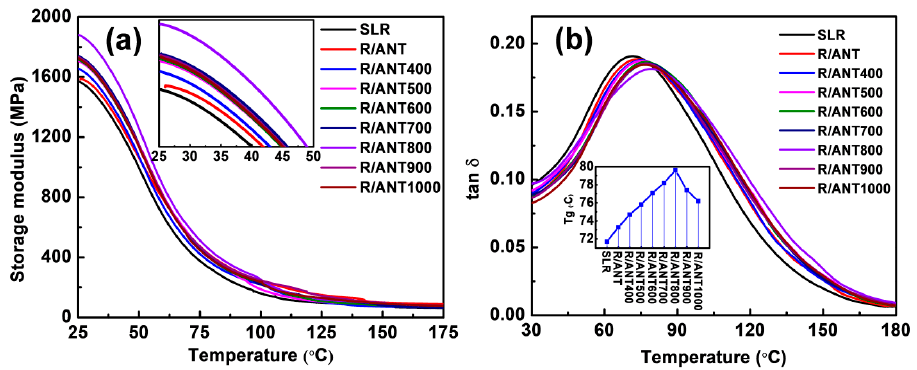
Figure 9. Thermo-mechanical analyses of neat SLR and SLR/nanofillers 3D printed samples. ( a ) Storage modulus and ( b ) tan δ curves. The inset in ( a ) shows the enlarged view of dynamic mechanical analysis (DMA) curves at a horizontal axis between 25 °C and 50 °C, and the inset in ( b ) shows the observed glass transition temperature (T g ) of different samples from the tan δ curve. Table 3. The glass transition temperature and storage modulus values of neat SLR and SLR with the fillers of annealed anatase TNPs at different calcinations temperatures.